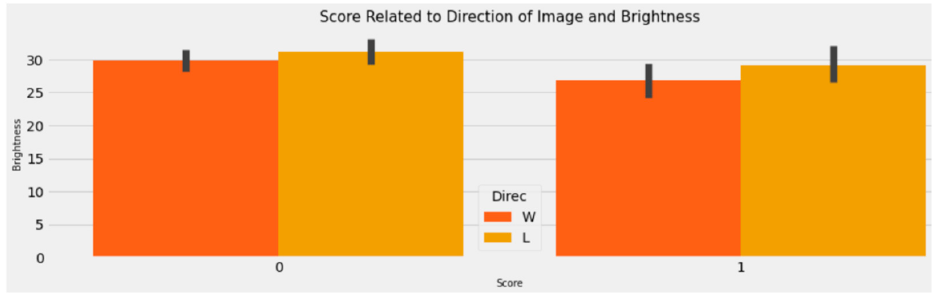
Figure 15. Relationship between the direction of the image to its brightness.